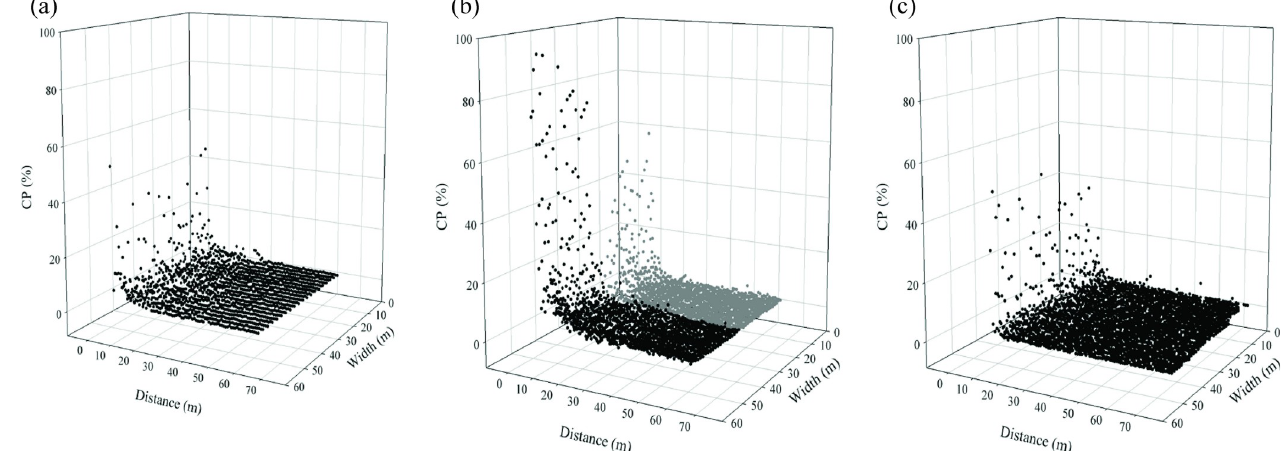
Fig 4. Scatter plots of pollen CP in the maize fields. Crop seasons (a) 2009–1, (b) 2009-2A (black dot) and 2009-2B (gray dot), and (c) 2010–1.